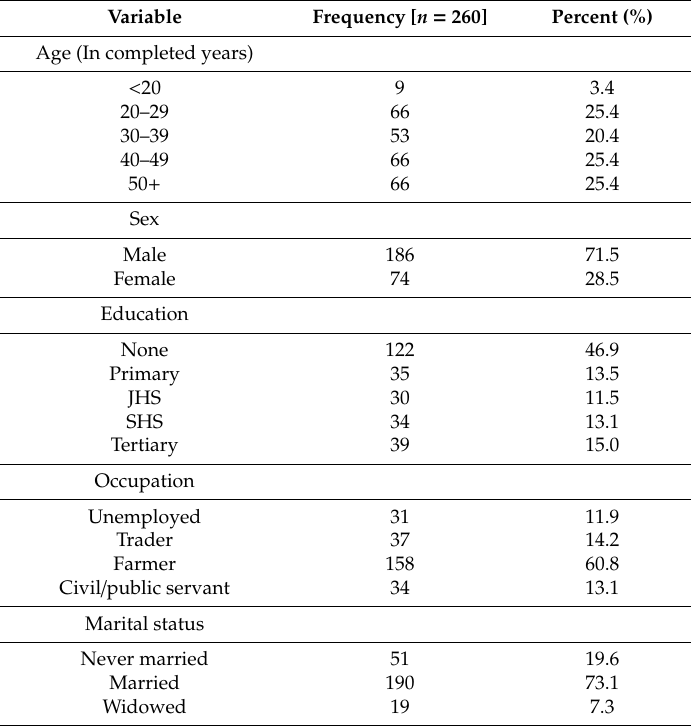
Table 1. Socio-demographic characteristics of respondents.